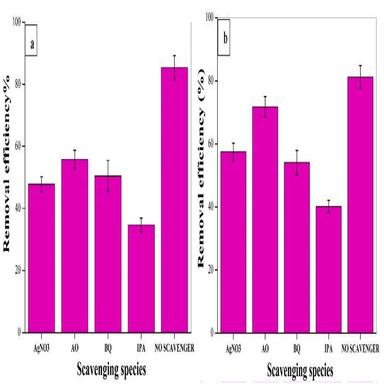
Radical trapping studies (a) UV–vis irradiation (b) Sunlight irradiation.